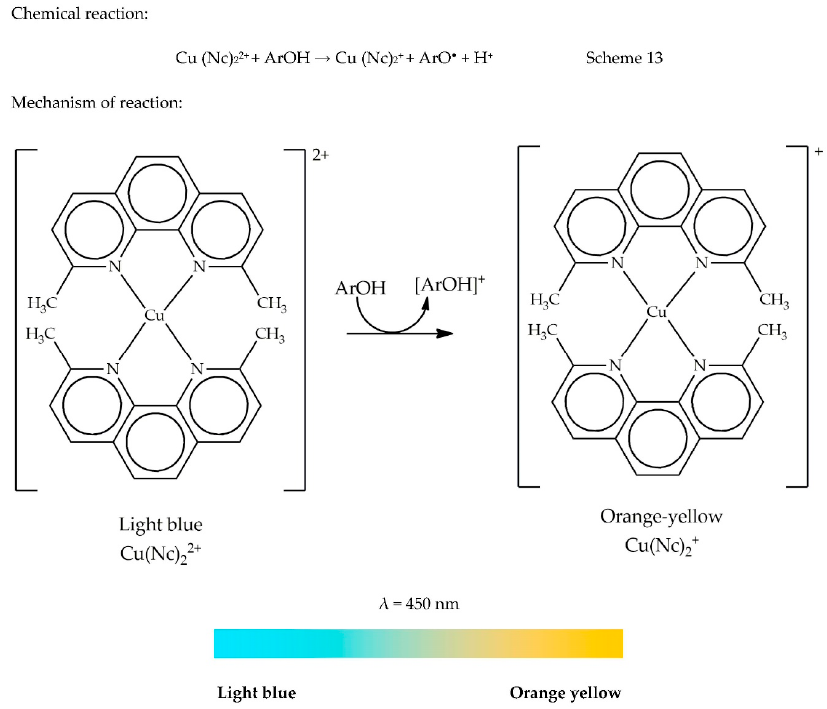
Figure 12. Cupric reducing antioxidant capacity ( CUPRAC) reaction mechanism.